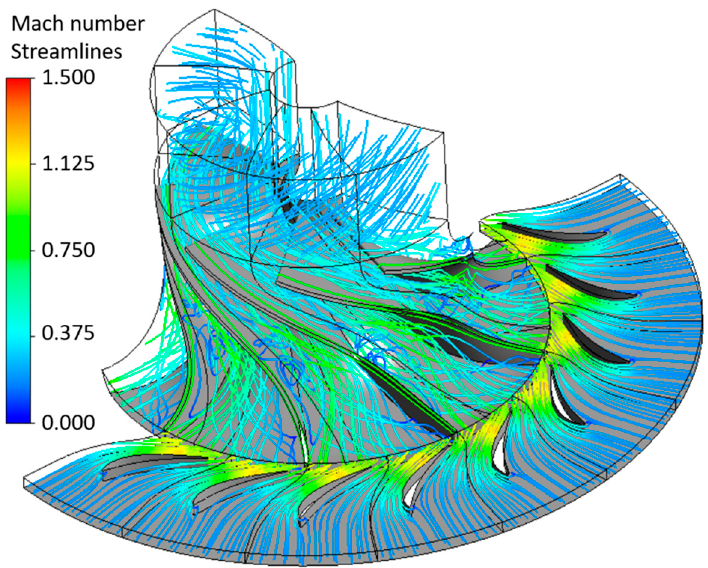
Figure 4. Velocity streamlines colored by Mach number through the designed turbine (stator + rotor).